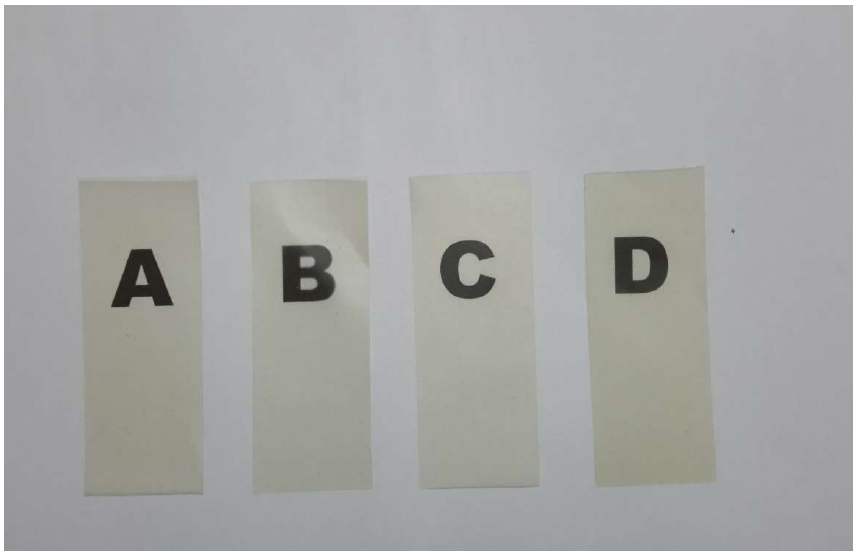
Figure 7. Typical photographic images of 30 µm-thick films of ( a ) κ-carr matrix; ( b ) κ-carr/CNC bionanocomposite; ( c ) κ-carr/OMMT bionanocomposite; and ( d ) hybrid κ-carr/CNC/OMMT bionanocomposite.